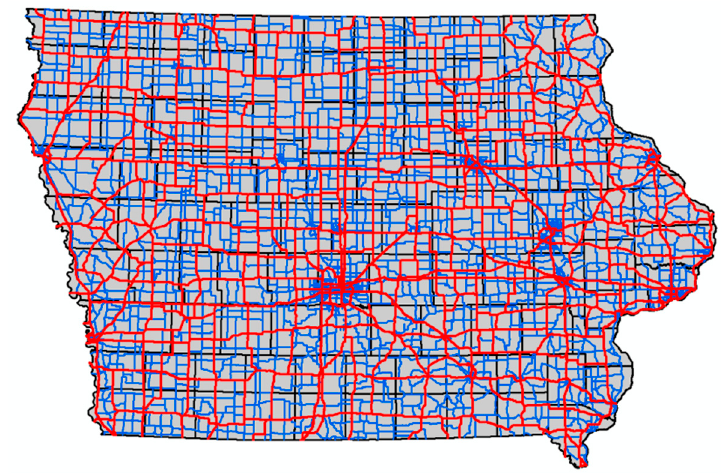
Figure 6. The study area road network.